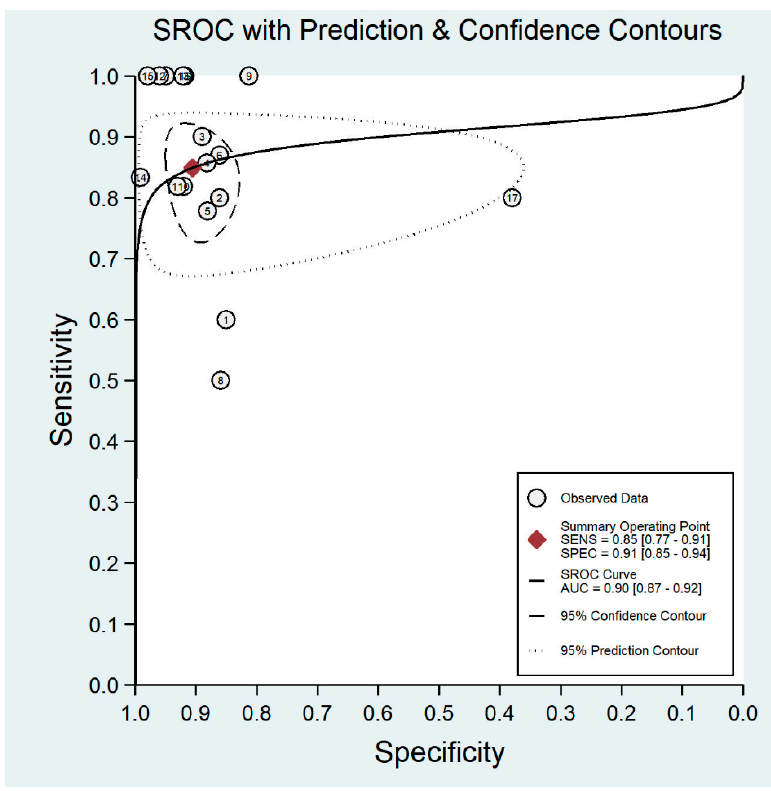
Figure 6. Receiver operating characteristic curve for mydriatic fundus imaging.